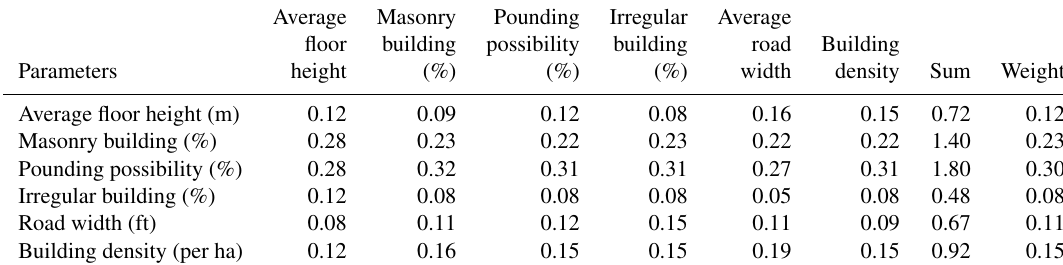
Table 5. Positive and negative ideal points used in the TOPSIS model. Vulnerability Positive ideal Negative ideal parameters point ( V + ) point ( V − ) 0.0171 0.0112